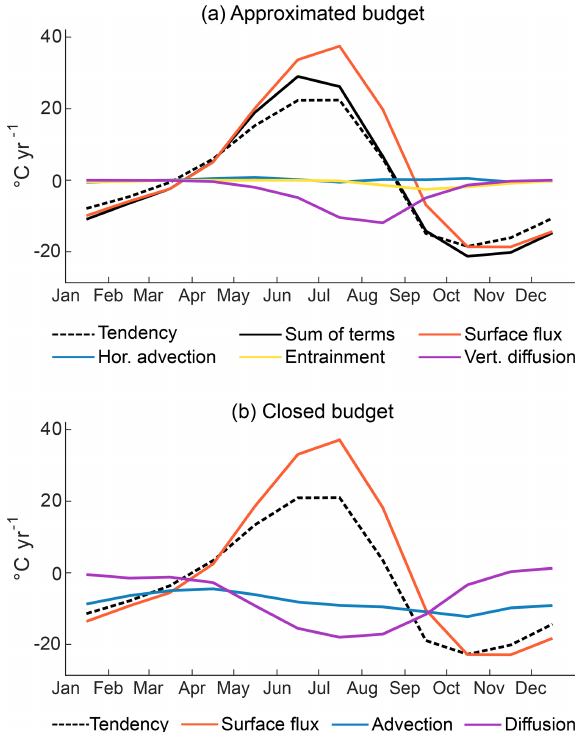
Figure 5. The average seasonal cycle of the dominant mixed-layer temperature budget terms ( ◦ Cyr − 1 ) averaged over the cold blob re- gion for ECCOv4-r4, where positive values represent an increase in the rate of change in the temperature of the mixed layer. (a) The ap- proximated budget computed using Eq. (1), where the black dashed line is the actual temperature tendency in the model and the solid line is the sum of the budget terms driving that temperature change. The remaining lines represent the temperature change due to each individual process: surface heat fluxes (orange), horizontal advec- tion (blue), vertical entrainment (yellow), and vertical diffusion (purple). Horizontal diffusion and lateral induction are not shown as the effects of both are negligible. (b) The closed budget computed online for comparison, where the dashed line is the tendency, which is equal to the sum of surface fluxes (orange), advection (blue), and diffusion